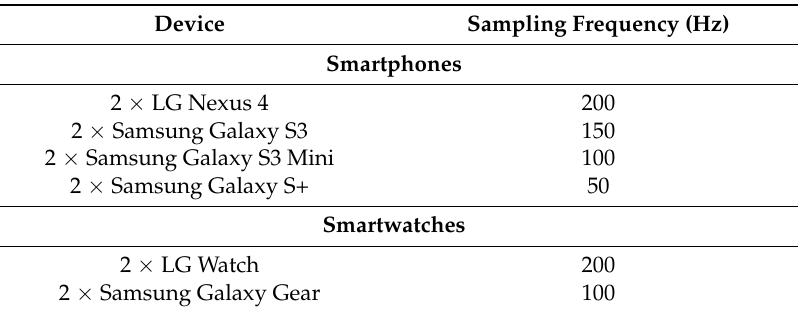
Table 1. Summary of the devices and their associated sampling frequencies